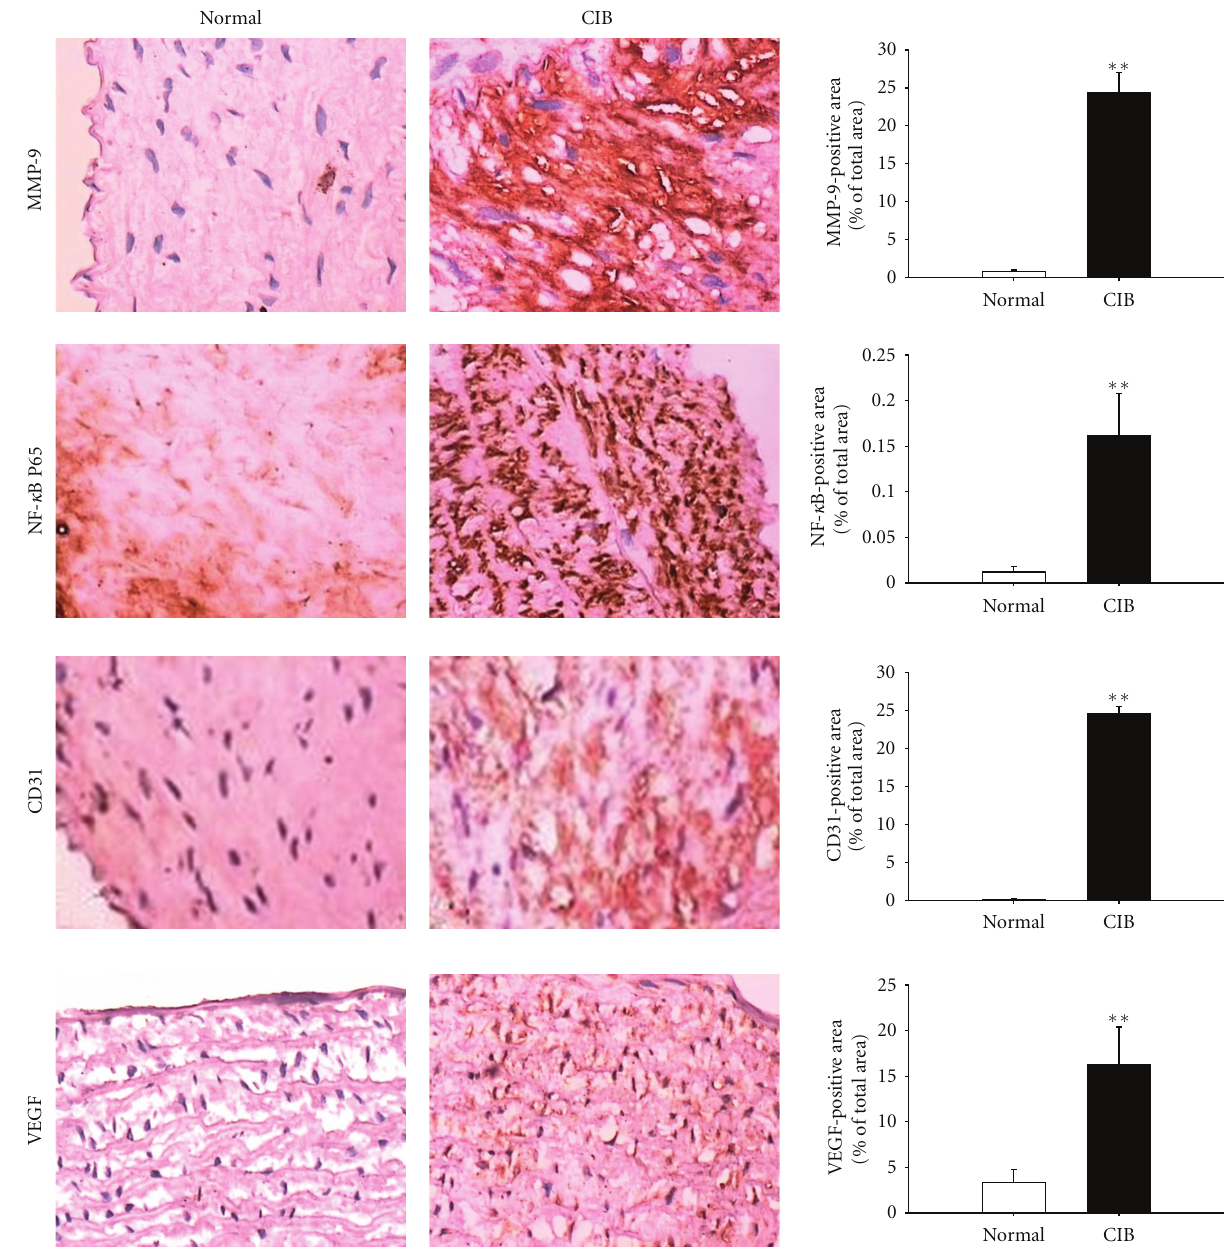
Figure 6: Representative immunohistochemical staining for MMP-9, NF- κ B P65 subunit, CD31 and VEGF. Strong positive staining was observed in CIB group and weak staining on the sections of arteries from normal group. MMP-9, matrix metalloproteinase-9; NF- κ B P65 subunit, nuclear factor- κ B P65 subunit; CD31, cluster of di ff erentiation 31; VEGF, vascular endothelial growth factor. Data are expressed as mean ± SD, ∗∗ P < 0 . 01 compared with